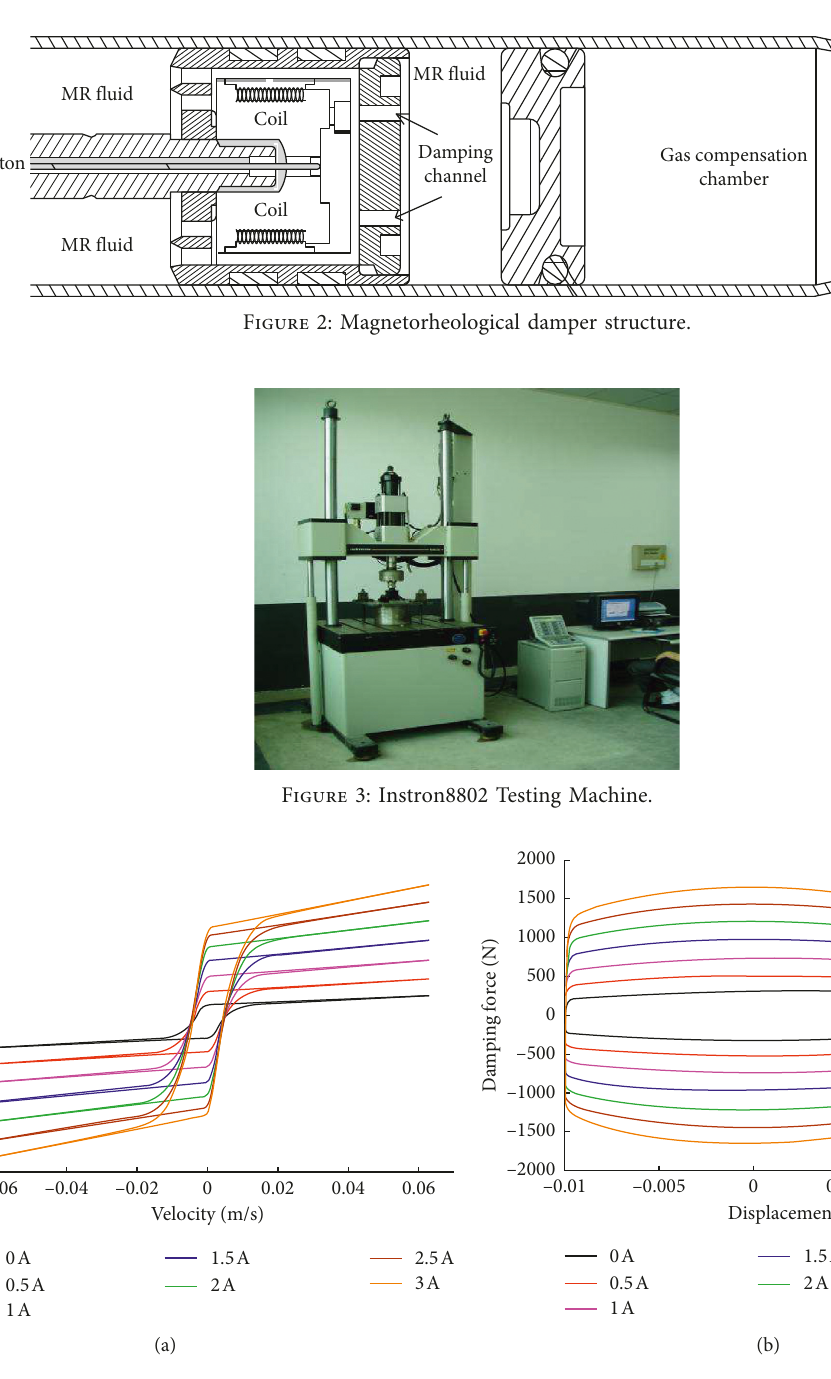
Figure 4: Experimental date of Amp (b) Piston displacement at different currents-damping force